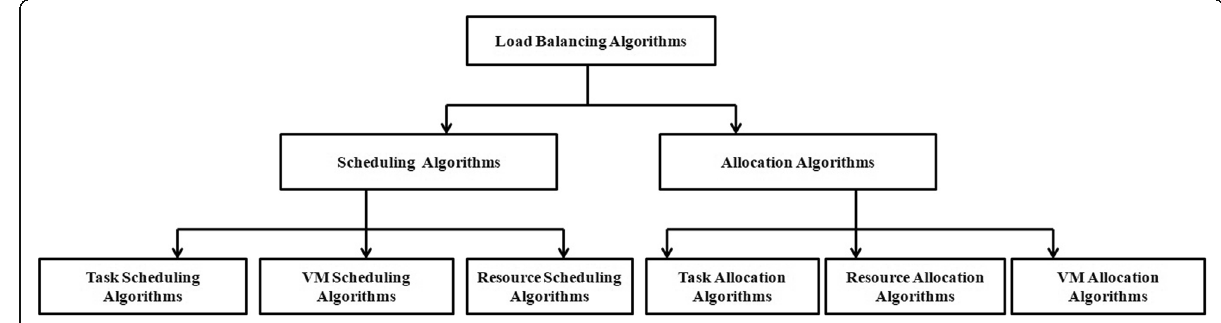
Fig. 3 Load balancing algorithms on the basis of nature and state of the